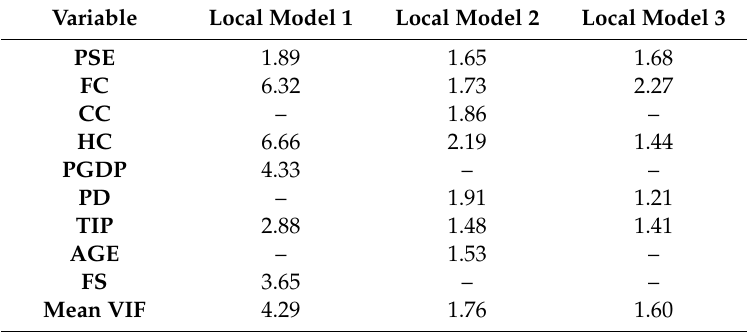
Table A2. Results of the multicollinearity test in the local